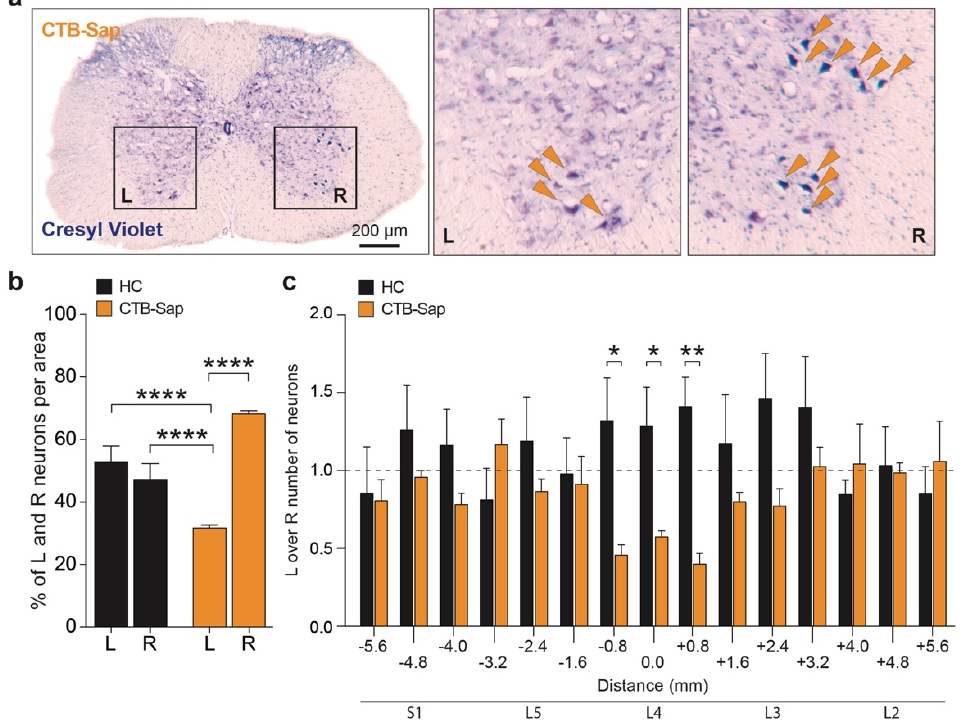
Figure 4. Permanent ablation of spinal MNs in Rexed lamina IX of CTB-Sap injected mice. ( a ) Representative pictures of cresyl violet staining on a 20 µ m axial section of the lumbar portion of the SC of CTB-Sap mice; orange arrows in the inserts indicate MN bodies, thus showing their reduced number in L compared to R side; ( b ) quantifications of the percentages of total neurons in the L and R side of the lumbar portion of the SC in HC and CTB-Sap mice; data are shown as mean ± SEM; **** p -value < 0.0001; one-way ANOVA and Holm-Sidak’s multiple comparisons test; ( c ) quantification of MNs in the SC (S1–L2) of HC and CTB-Sap mice; data are shown as mean ± SEM; * p -value < 0.05; **